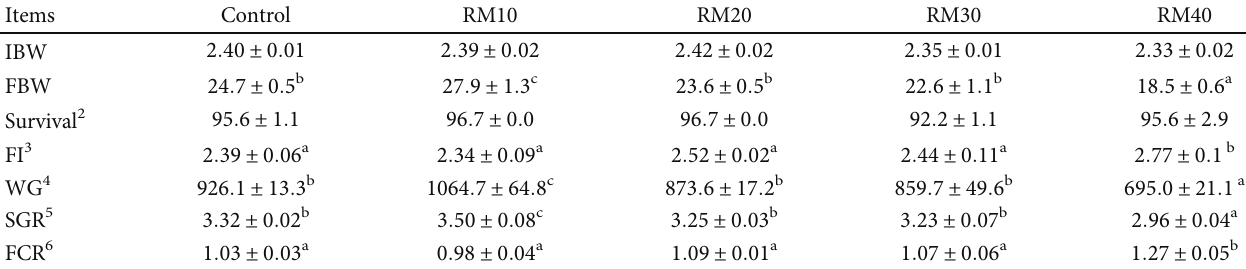
Table 3: E ff ects of mixed plant protein substitute for fi sh meal on growth performance and feed utilization of yellow cat fi sh. Items